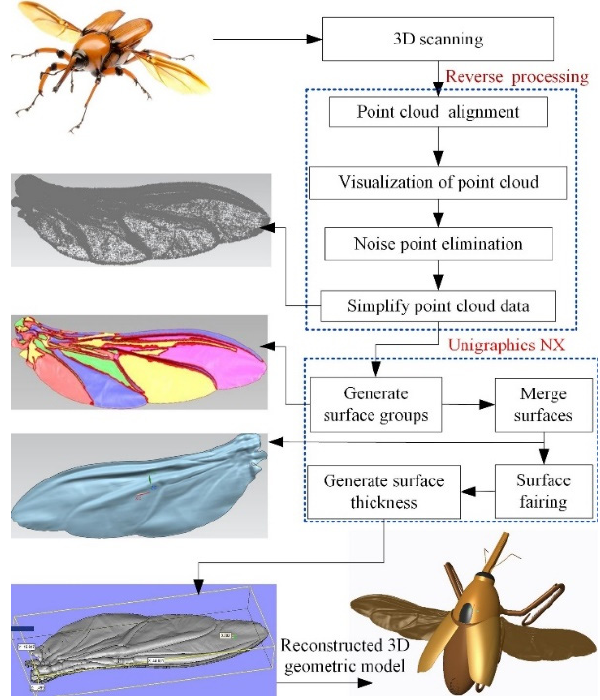
Figure 1. Reverse reconstruction of the specimen.